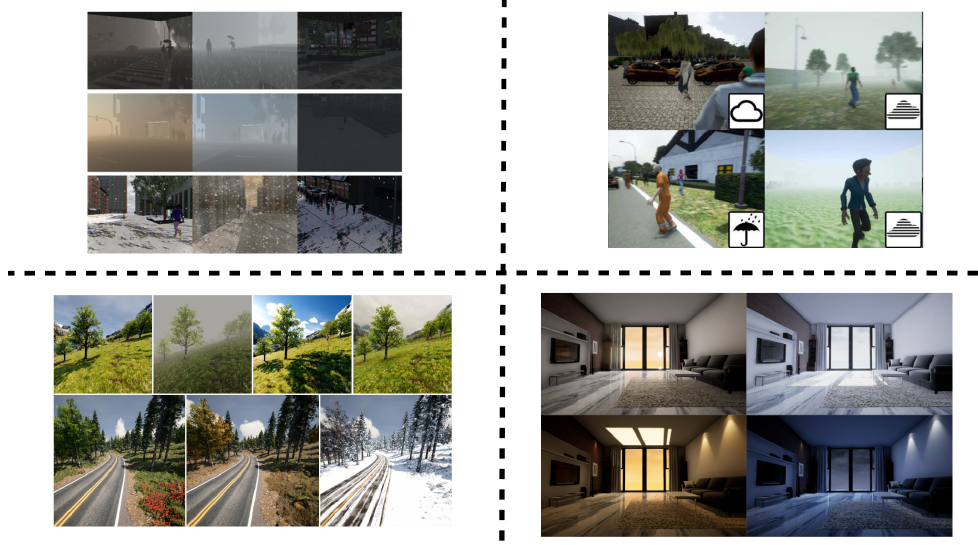
Figure 4. Examples of synthetic images generated by 3D simulators. Please refer to the original papers for more information. ( Upper left ) Kerim et al. [55]. ( Upper right ) De Souza et al. [42]. ( Bottom left ) Fonder et al. [35]. ( Bottom right ) Hwang et al.